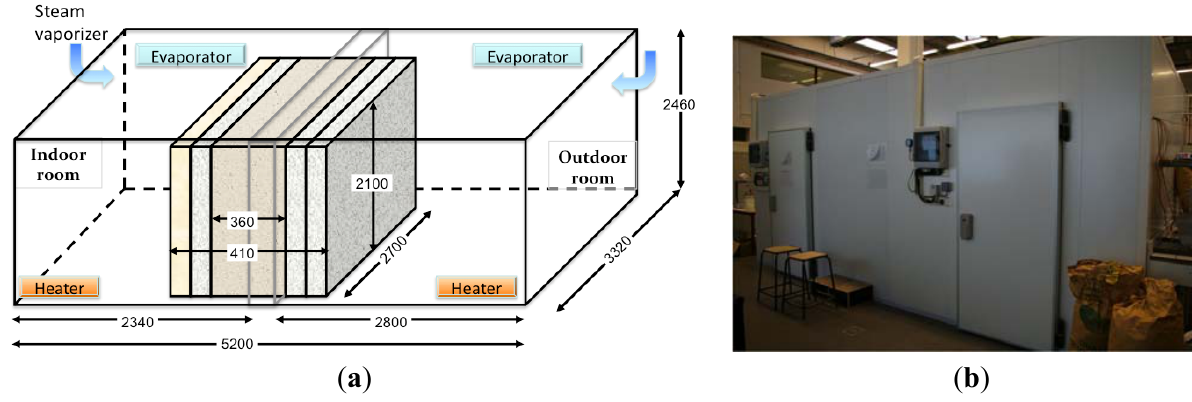
Figure 1. ( a ) Schematic of the two climatic rooms separated by the hemp concrete wall. ( b ) Picture of the experimental device.